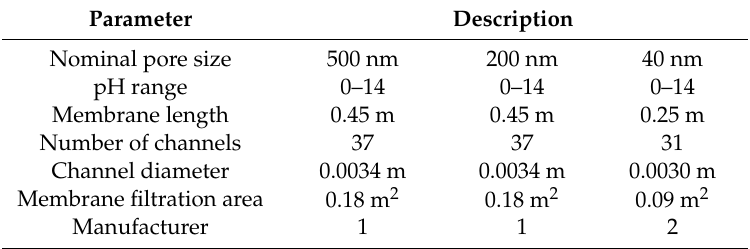
Table 4. Characteristics of the SiC microfiltration (MF) and ultrafiltration (UF) membranes. Membrane manufacturer: 1 = Saint-Gobain Industrie Keramik Roedelheim GmbH, Roedental, Germany; 2 = LiqTech International A / S, Ballerup,